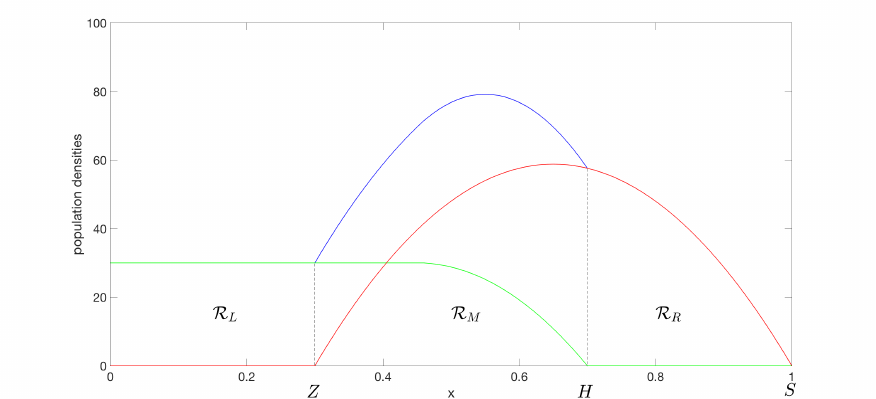
Figure 1. Initial conditions for the competition system, with population density u of species 1 in green and v of species 2 in red. The blue shows the initial combined population density ( u + v ). The outer boundaries are x = 0 (fixed) and x = S ( t ) (free), while the interfaces are at x = Z ( t ) (green/blue) and x = H ( t ) (blue/red). The two interfaces are indicated by dotted lines and separate the domain into the three regions R L , R M , and R R